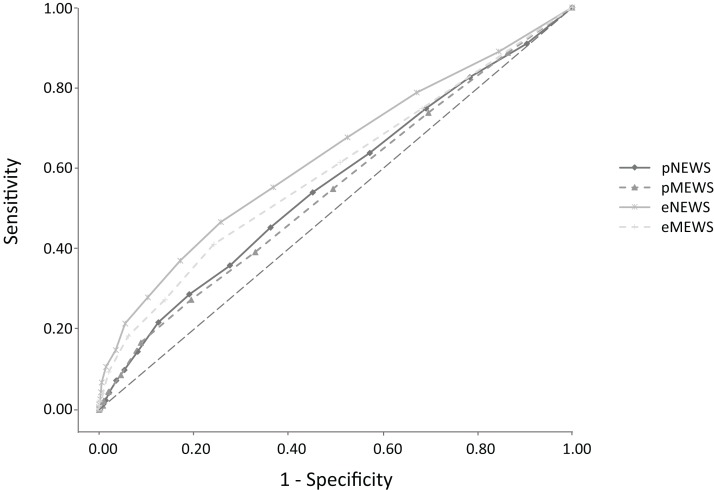
Receiver operator characteristic (ROC) curves for admission comparing the Early Warning Scores in the pre-hospital and in the emergency department.